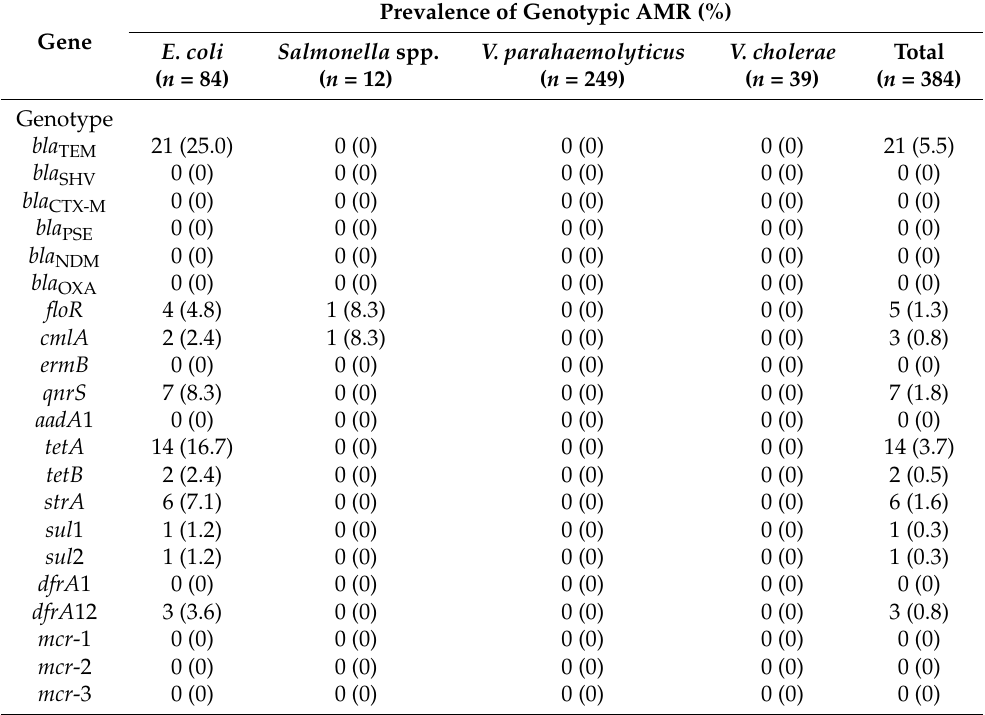
Table 3. Genotypic characterization of AMR and their